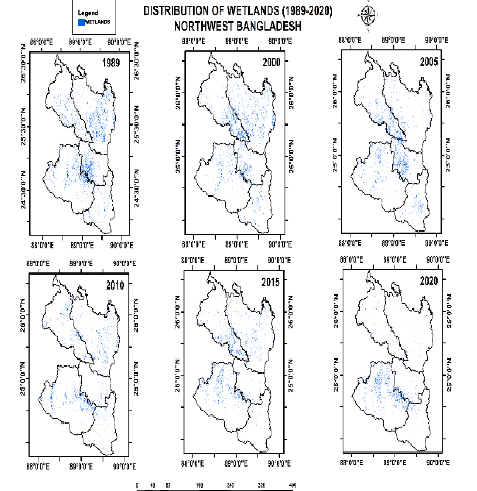
Figure 3 . Spatiotemporal distribution of wetlands in NW Bangladesh. Table 4 . Wetland areal coverage changes in Northwest